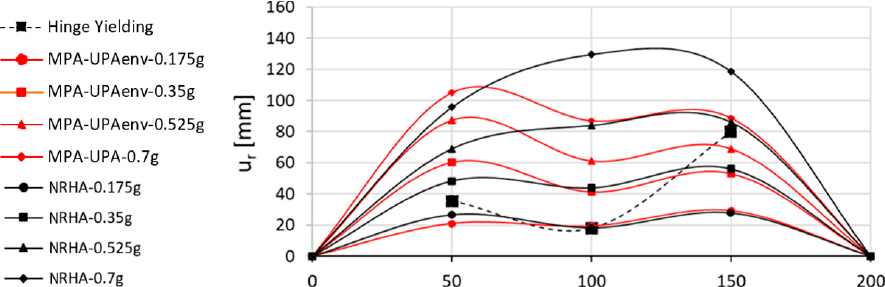
Figure 19. Irregular bridge—deck displacements derived by performing nonlinear dynamic analysis and pushover analysis according to the approaches considered (PGA from 0.175 to 0.7 g).